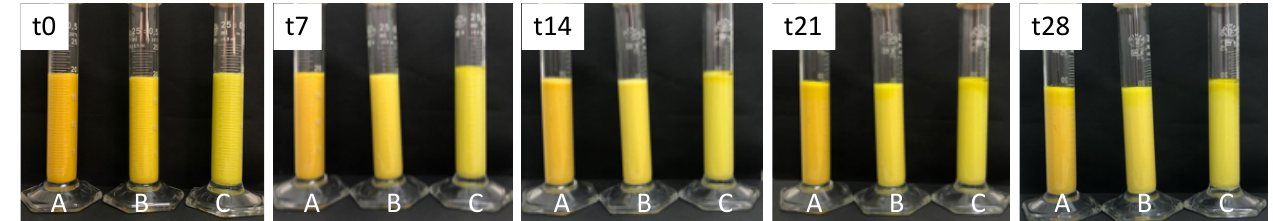
Figure 4. Photographic registration of the cream index evolution along time (0, 7, 14, 21, and 28 days) for the produced emulsions: KC1 φ 0.4 (4.7%) (A), KC2 φ 0.4 (4.7%) (B), and KC2 φ 0.6 (4.0%) (C).